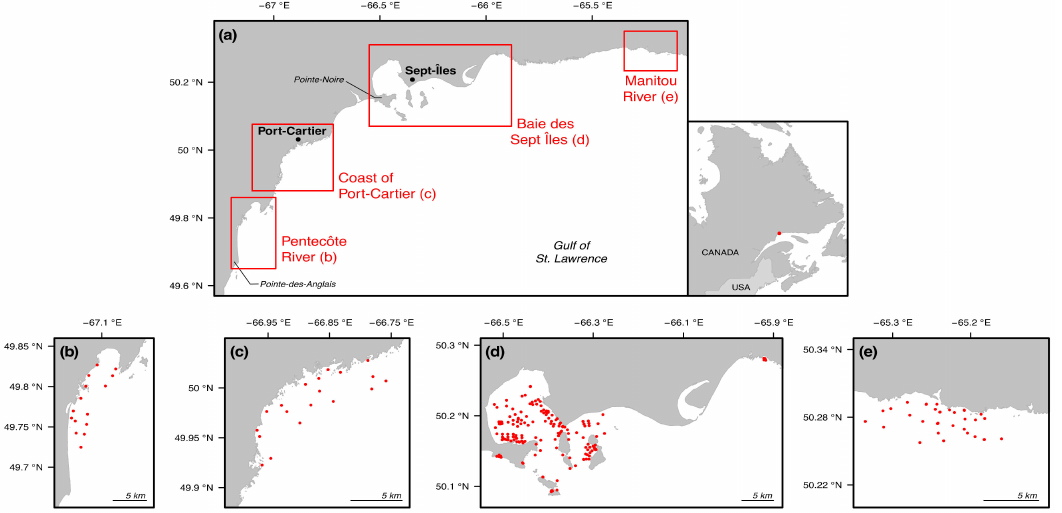
Figure 1. Maps of the study area. ( a ) Location of the considered sectors; ( b ) Stations sampled in the Pentec ô te River sector; ( c ) stations sampled in the coast of Port-Cartier sector; ( d ) stations sampled in Baie des Sept Îles sector; ( e ) stations sampled in the Manitou River